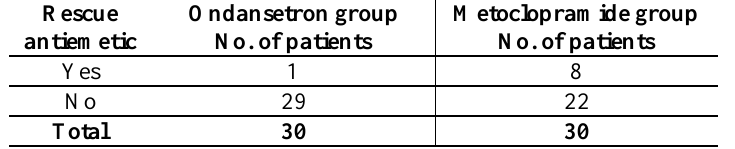
? 2=4.71 (Yates), p=0.03 Table III : Average Pethidine received by two study-groups (intra-operative & post-operative)